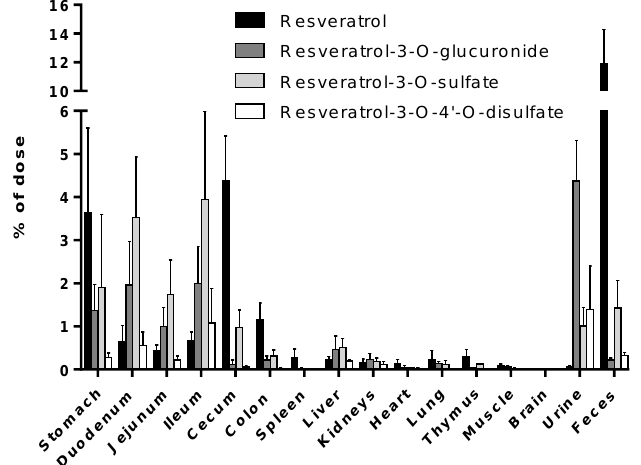
Figure 4. Recovery of resveratrol and its metabolites in mice tissues after a single gastric gavage (0–8 h) as a percentage of the total amount administered. Values are presented as the mean ± SD; n = 3.